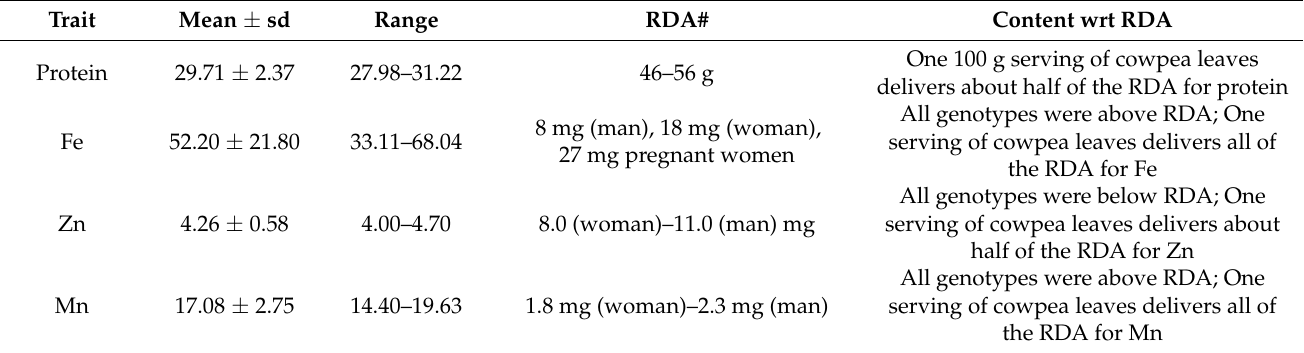
Table 6. Grand means, standard deviation (sd), and range for nutrient traits compared with the Recommended Daily Allowance (RDA) and average nutritional delivery in a 100 g serving of cowpea leaves and correlation of iron (Fe), zinc (Zn), and manganese (Mn) with protein content.